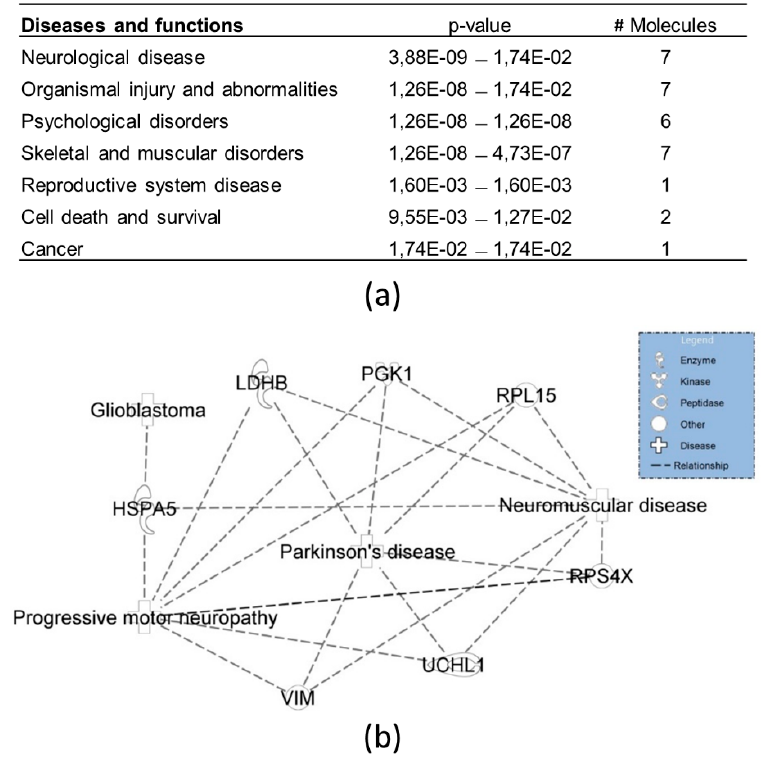
Figure 4. Top diseases and biological functions related to the hNgb protein interactors in a non-stress condition. ( a ) Network analysis by Ingenuity Pathway Analysis reveals the 24 specific hNgb interactors to be specifically linked to neurological diseases and organismal injury and abnormalities. The proteins involved are: 78 kDa glucose-regulated protein (HSPA5), L-lactate dehydrogenase B chain (LDHB), phosphoglycerate kinase 1 (PGK1), 60S ribosomal protein L15 (RPL15), 40S ribosomal protein S4 X isoform (RPS4X), ubiquitin carboxyl-terminal hydrolase isozyme L1 (UCHL1), and vimentin (VIM). ( b ) Function annotations of the neurological diseases network show a clear link to motor neuropathies.